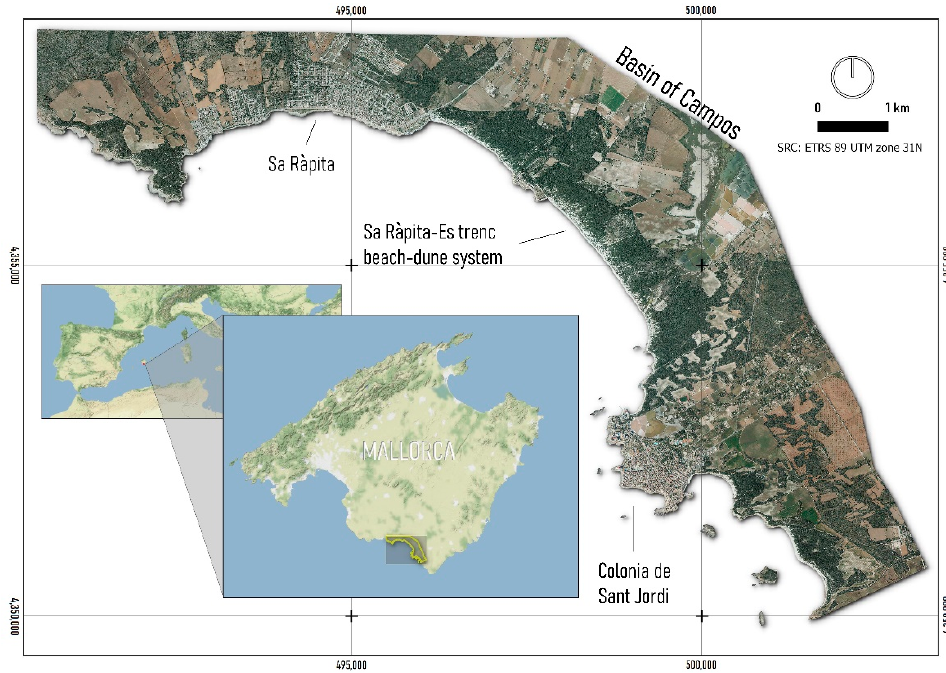
Figure 1. Location and overview of the study area .